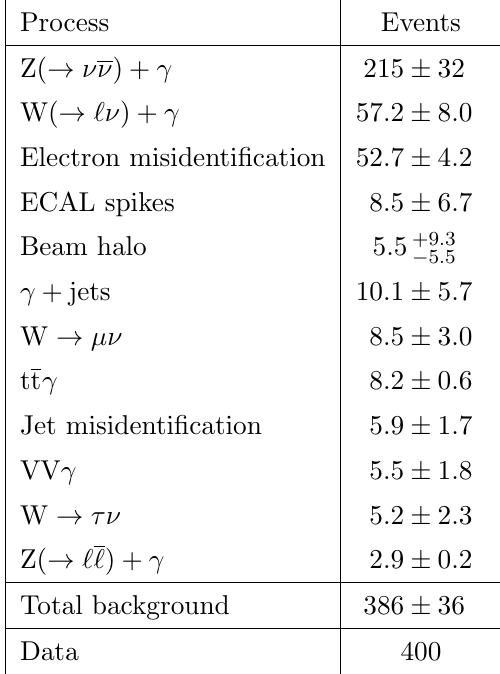
Table 1 . Summary of estimated background and observed candidate events. The quoted uncertain- ties for the background estimates are obtained by adding the systematic and statistical uncertainties in quadrature.